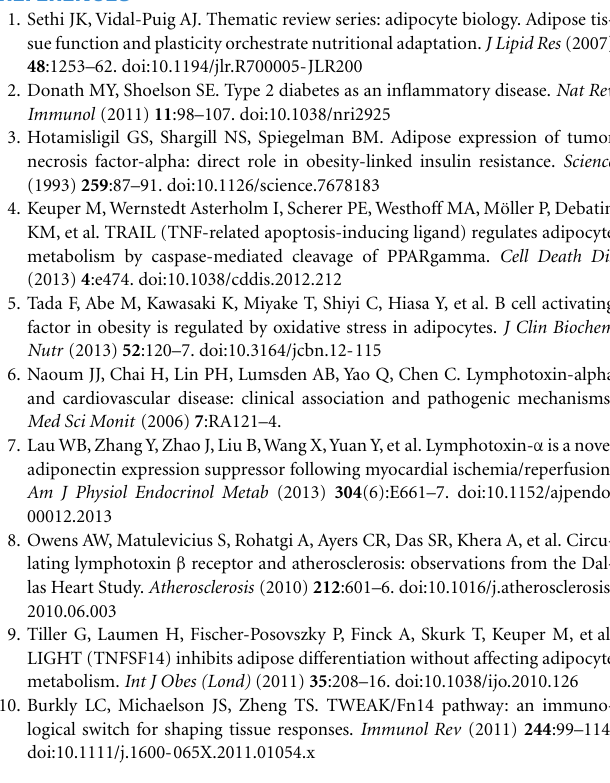
FIGURE 1 | Model of the state of the art of TWEAK and TNF α in obesity and T2D conditions . In obesity and T2D states, higher circulating levels of TNF α and lower levels of sTWEAK have been observed. Additionally, obese adipose tissue is highly infiltrated with macrophages that could be a source of sTWEAK production and also express mTWEAK on the surface.The latter may establish a strong pro-inflammatory response in adipocytes where the Fn14 receptor is over-expressed and activates the NF- κ B pathway. In contrast, sTWEAK has been identified as a negative regulator of TNF α signaling since both